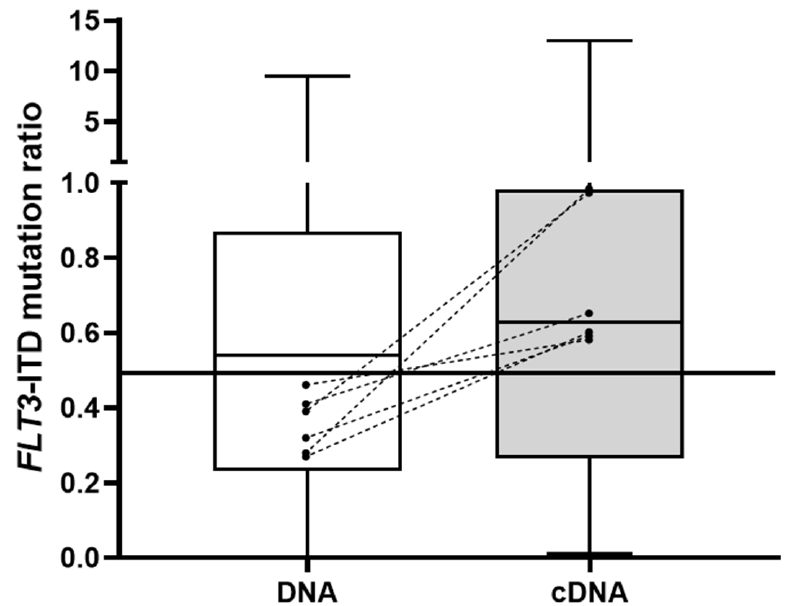
Figure 2. Boxplots showing the comparison of FLT3 -ITD mutation AR between DNA and cDNA samples. The six cases in which ELN risk stratification changed from intermediate-risk to high-risk AML in cDNA are represented by dashed lines.